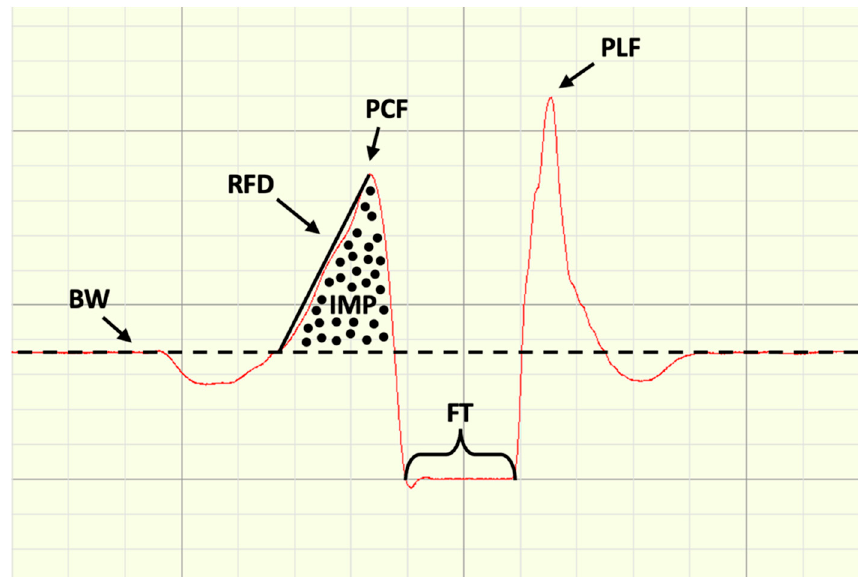
Figure 2. Graphical representation of kinetic variables examined in the present study. PCF = peak concentric force; PLF = peak landing force; RFD = rate of force development; BW = body weight; IMP = impulse; FT = flight time.